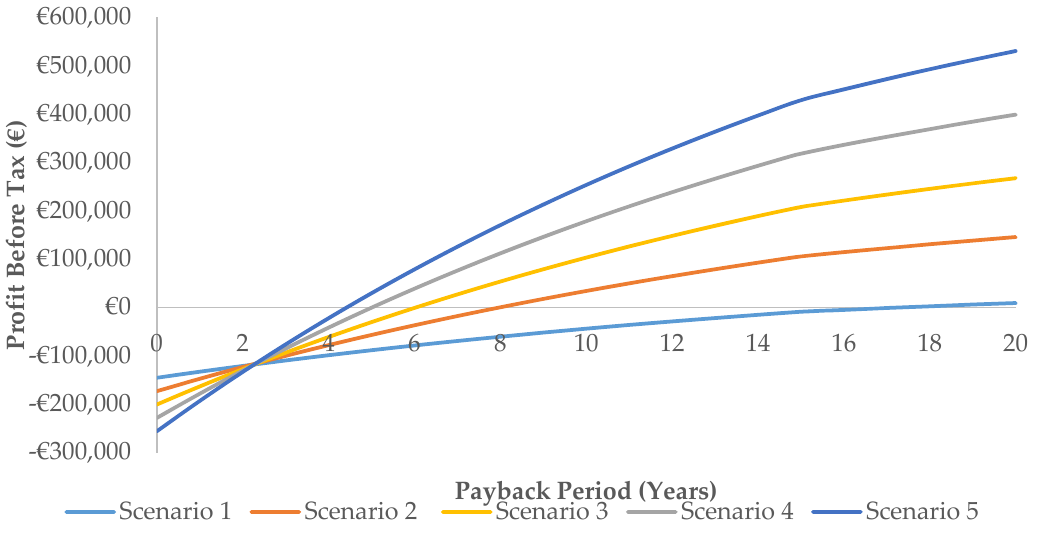
Figure 6. Comparison of discounted payback periods of scenarios (including 50% capital subvention grant).